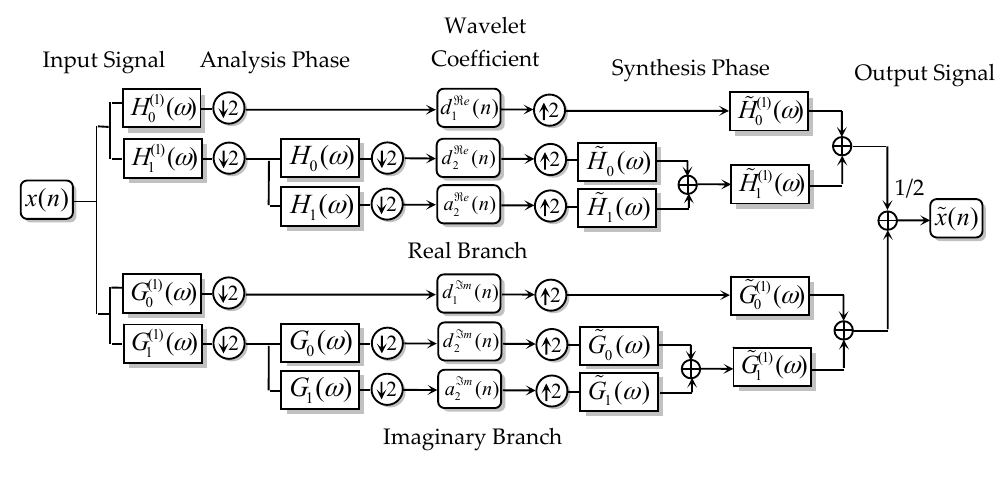
Figure 4. Filter bank topology of dual tree complex wavelet transform.